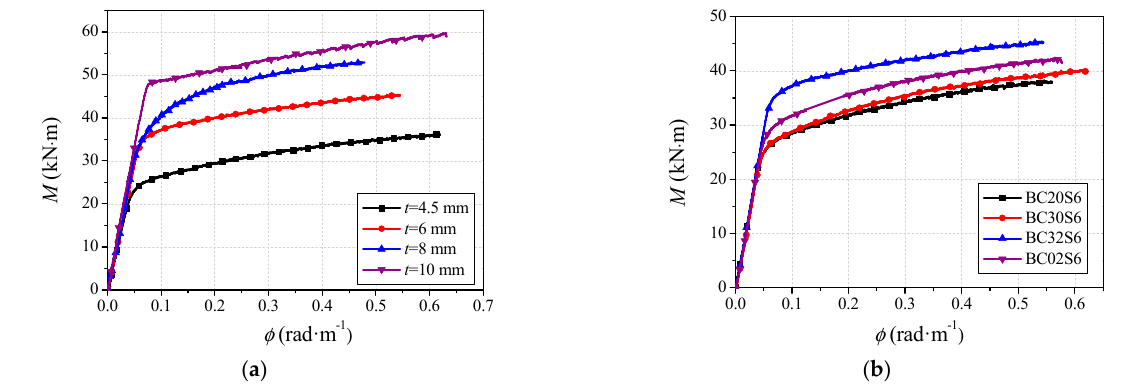
Figure 7. Moment ( M )-versus-curvature ( φ ) curves. ( a ) The effect of steel tube wall thickness; ( b ) the effect of CA-UHPC